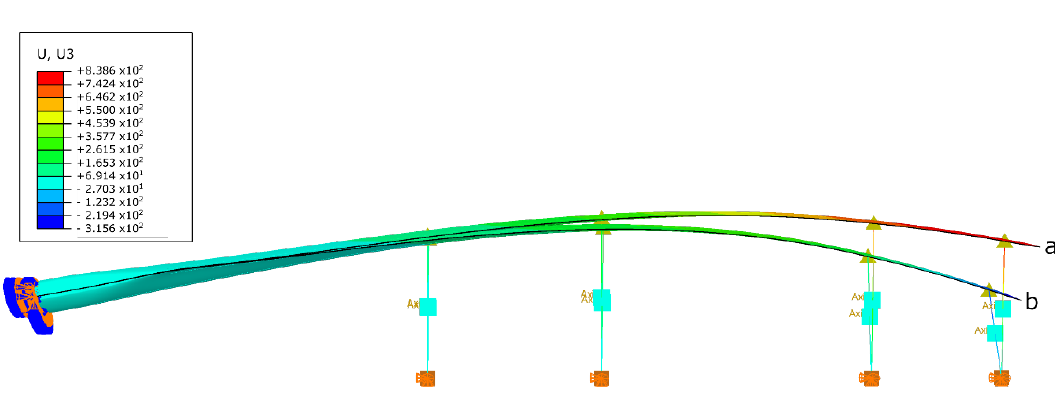
Figure 6. Contour plots of the displacements in the z -direction of the conventional OML shell model on the deformed shape under static load. ( a ) The result obtained from a geometrically linear calculation; ( b ) the result from a geometrically nonlinear calculation.